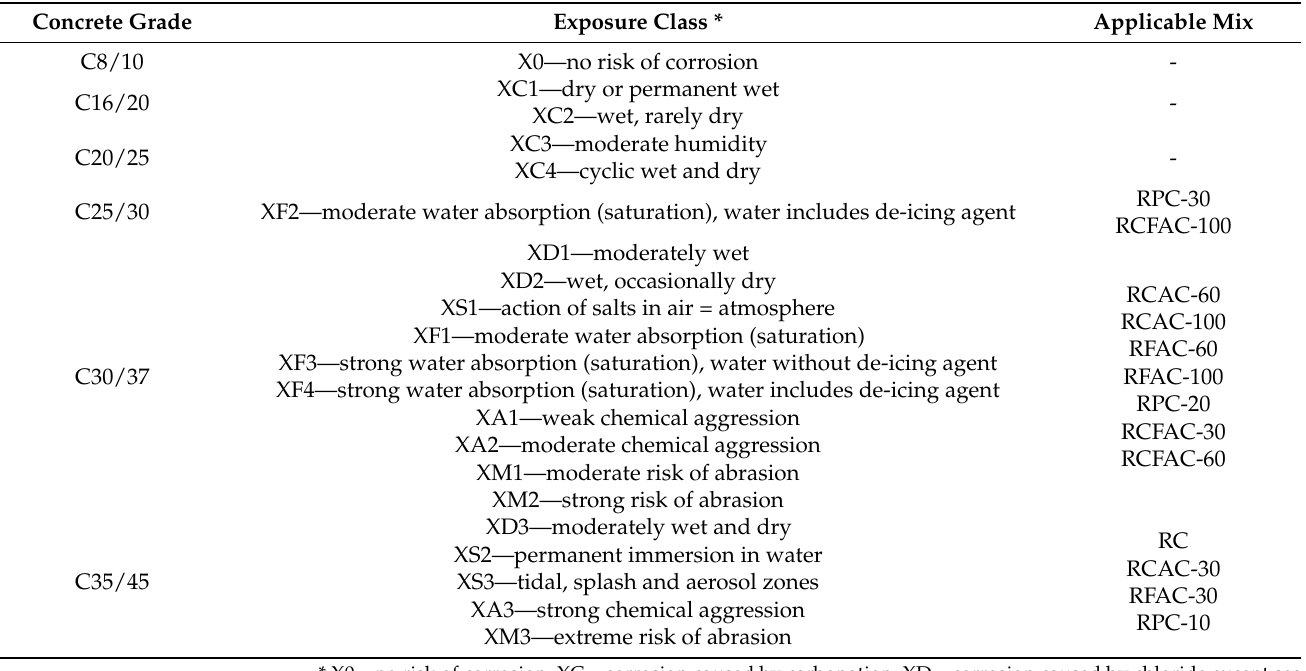
Table 6. Environmental exposure conditions based on compressive strength of